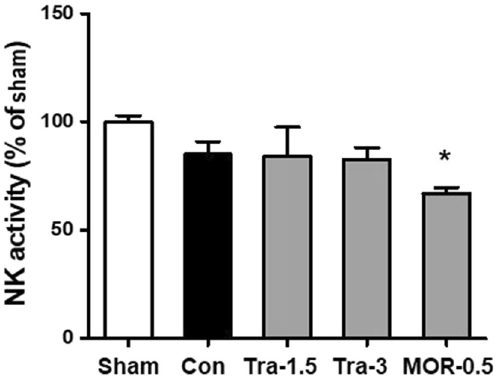
Figure 4. Natural killer cell activity in whole blood of MCF-7 tumor-bearing nude mice. Whole blood samples were collected from mice 4 weeks after orthotopic inoculation of MCF7-Luc cells. Sham, healthy mice not bearing cancer; control group; Tra-1.5, tramadol 1.5 mg kg −1 day −1 ; Tra-3, tramadol 3 mg kg −1 day −1 ; MOR-0.5,